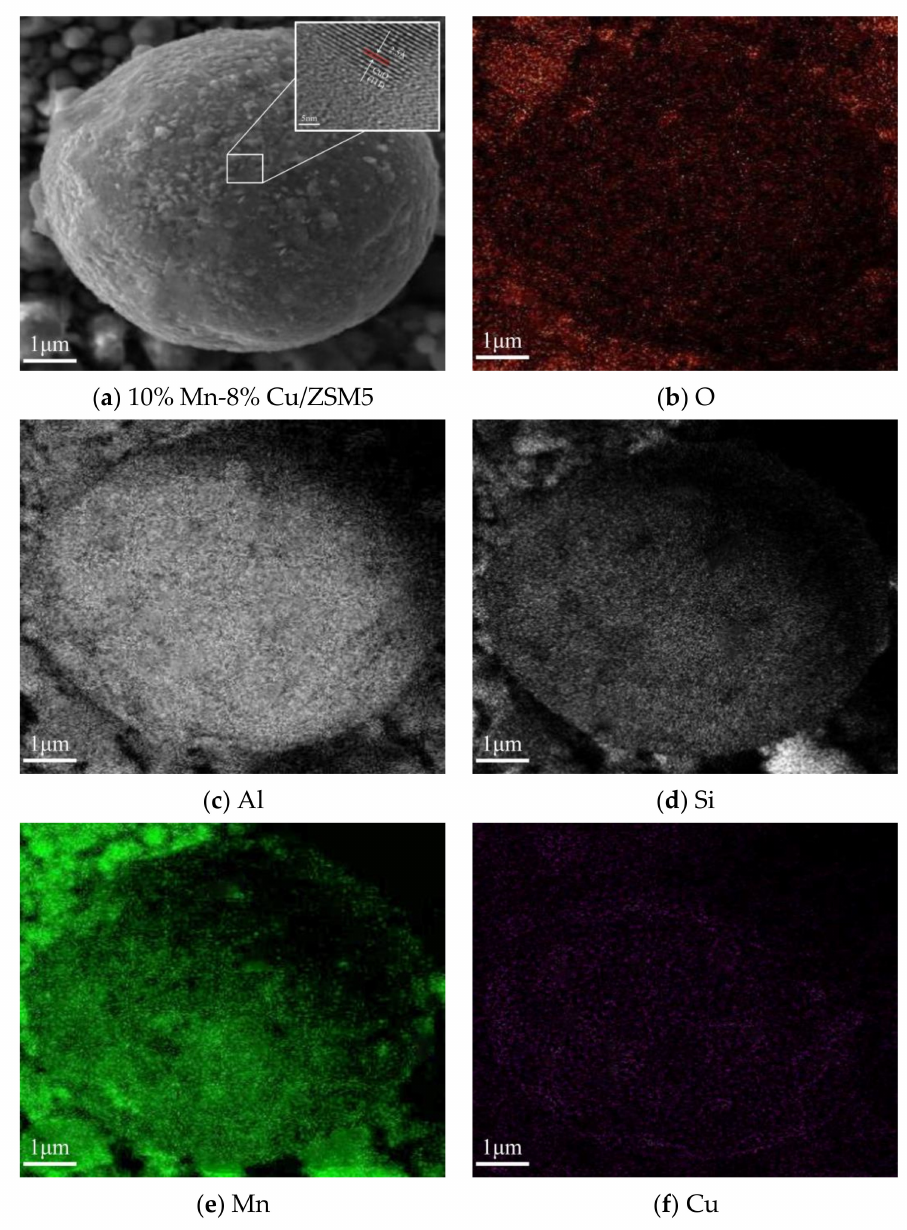
Figure 1. SEM, HRTEM and EDS images of the 10% Mn-8% Cu / ZSM5